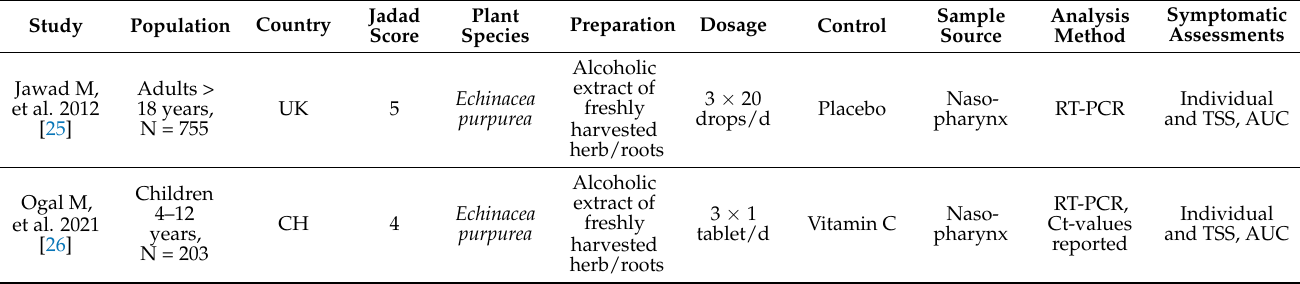
Figure 1. PRISMA flow chart for systematic reviews detailing the database searches, the number of publications screened, and eligible results retrieved. Table 1. Included studies with details on methodology and outcome.